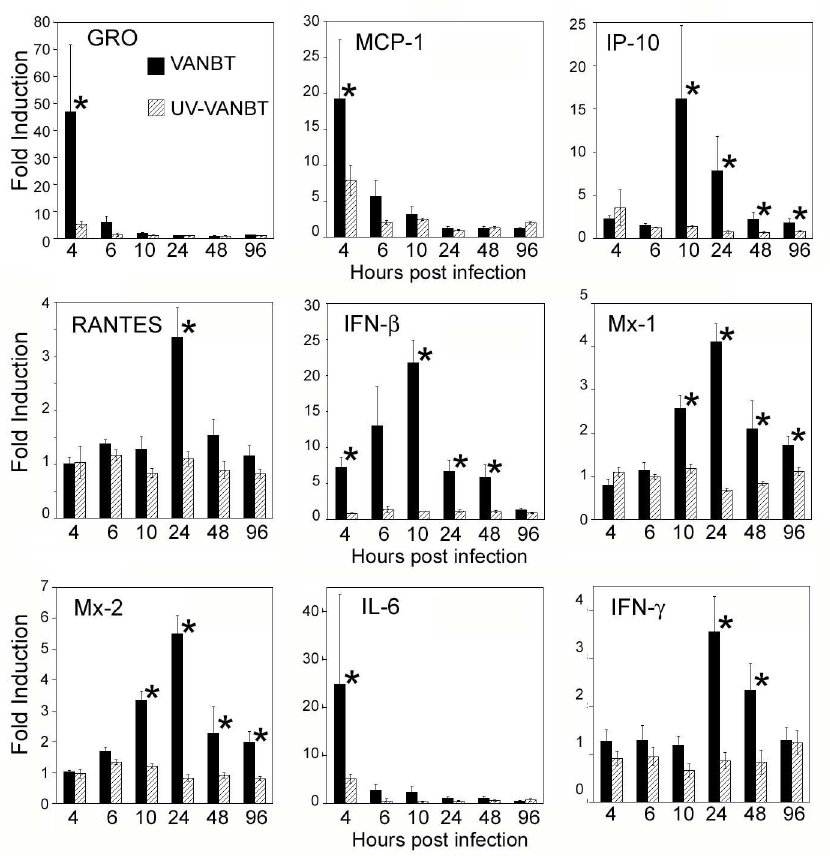
Fig 2. VANBT infection in cotton rats induces pulmonary chemokine, IFN, and proinflammatory cytokine mRNA expression. Cotton rats were infected i.n. with 10 6 TCID 50 of VANBT or the same amount of UV-VANBT. Groups of 4 animals were euthanized at each indicatedtime point. Results are representative of two independent experiments. Relativegene expression profile of chemokines (GRO, MCP-1, IP-10 and RANTES), IFN- β , two IFN-inducible genes (Mx-1 and Mx-2), and pro-inflammatory cytokines (IL-6 and IFN- γ ) in the lung tissues were measured by qRT-PCR. Results are calculated as fold inductionover uninfected (na ï ve) animals and expressedas geometric means ± SE, * p < 0.05 for VANBT compared with UV-VANBT at each time